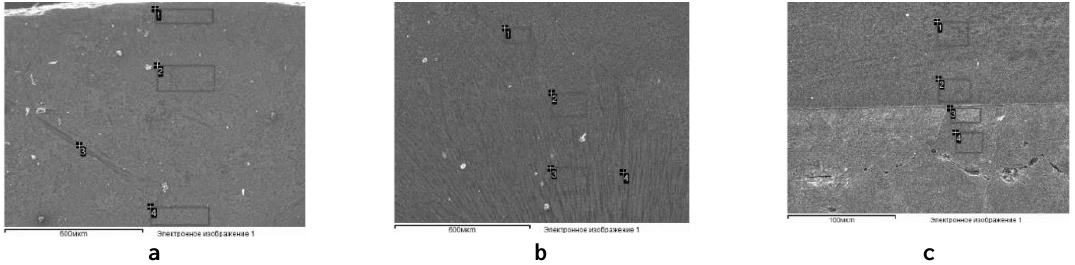
Fig.10. Electronic photographs of the structure of the surfaced stripes with T-620 electrode indicating XREPA zones: